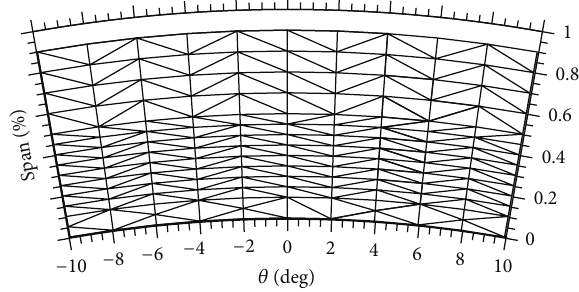
Figure 15: Initial measurement grid, 165 points.